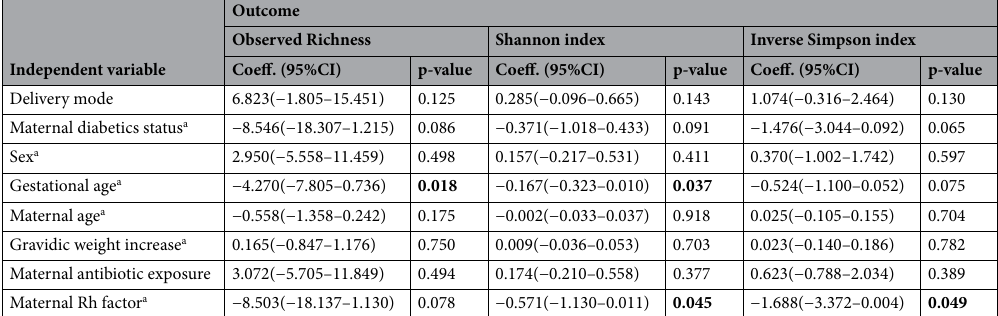
Outcome Observed Richness Shannon index Inverse Simpson Independent variable